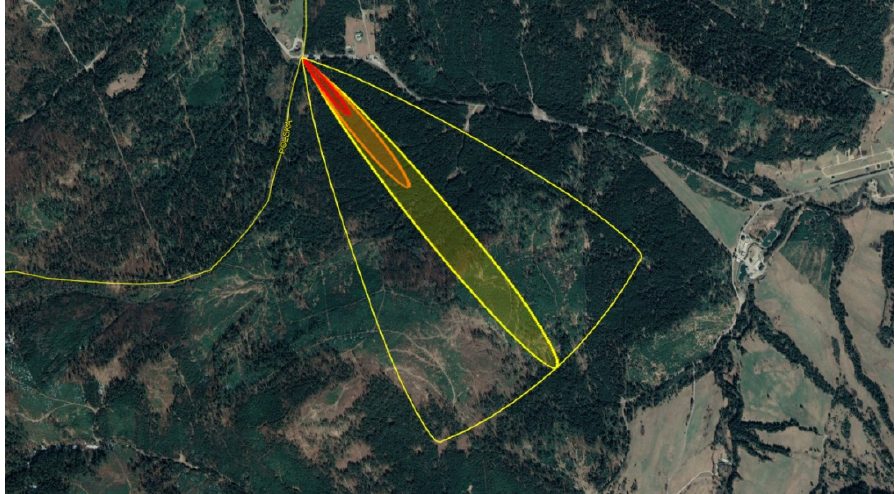
Figure 10. Graphical representation of the dispersion of a dangerous substance at the border crossing Oravská Polhora-Korbielow [24,25].